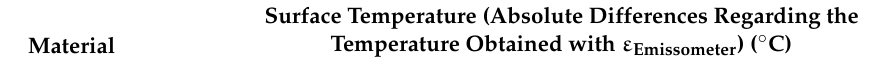
Table 9. Surface temperature measured with IRT (emissivity with the emissometer, IRT and the camera in manual mode) and absolute differences between the